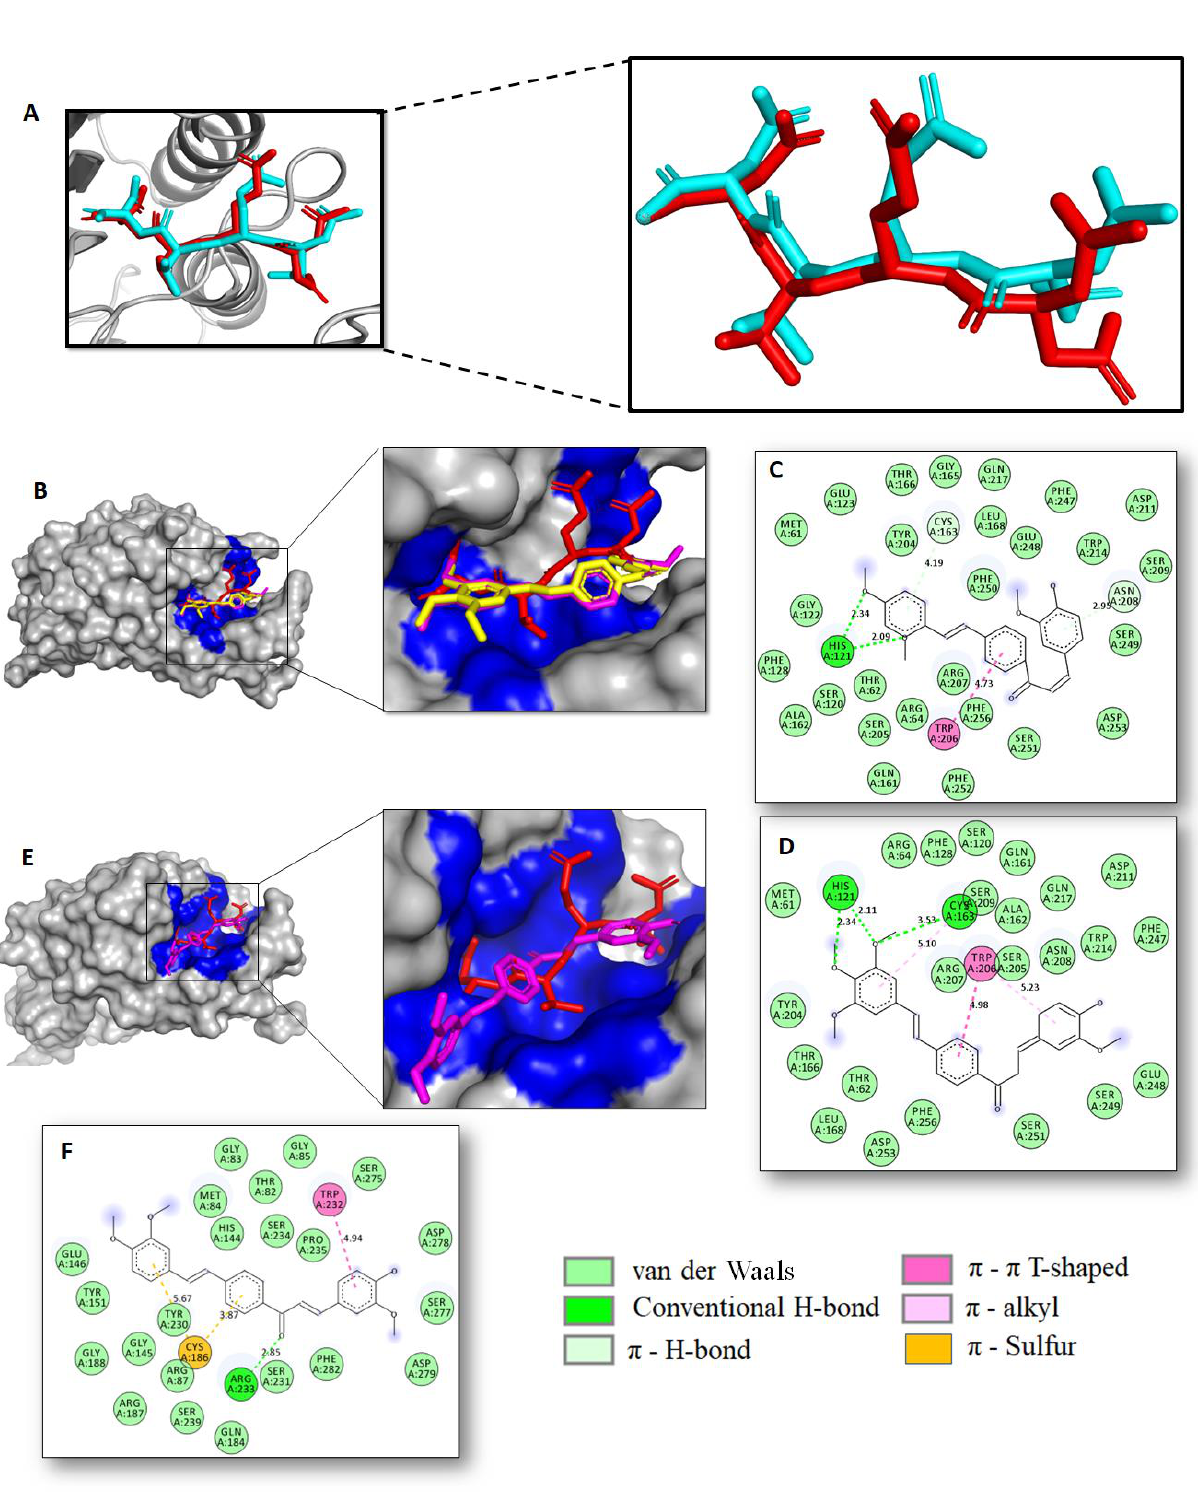
Figure 9. ( A ) Self-docking validation. Alignment of the best-docked pose of Ac-DEVD-CMK (in cyan) and the crystallographic binding mode (in red). ( B ) Superposition of the best docked conformations of hybrids 3i (magenta) and 3k (yellow), and crystallographic binding mode of inhibitor Ac-DEVD-CMK (red) within the caspase-3 active site. ( C , D ) 2D protein–ligand plot interaction for 3i and 3k into the caspase-3 domain. ( E ) Superposition of the best docked conformation of hybrid 3i (magenta) and crystallographic binding mode of inhibitor Ac-DEVD-CHO (red) within the caspase-7 active pocket. ( F ) 2D protein–ligand plot interaction for 3i into the caspase-7 active site. Catalytic residues are colored in blue.